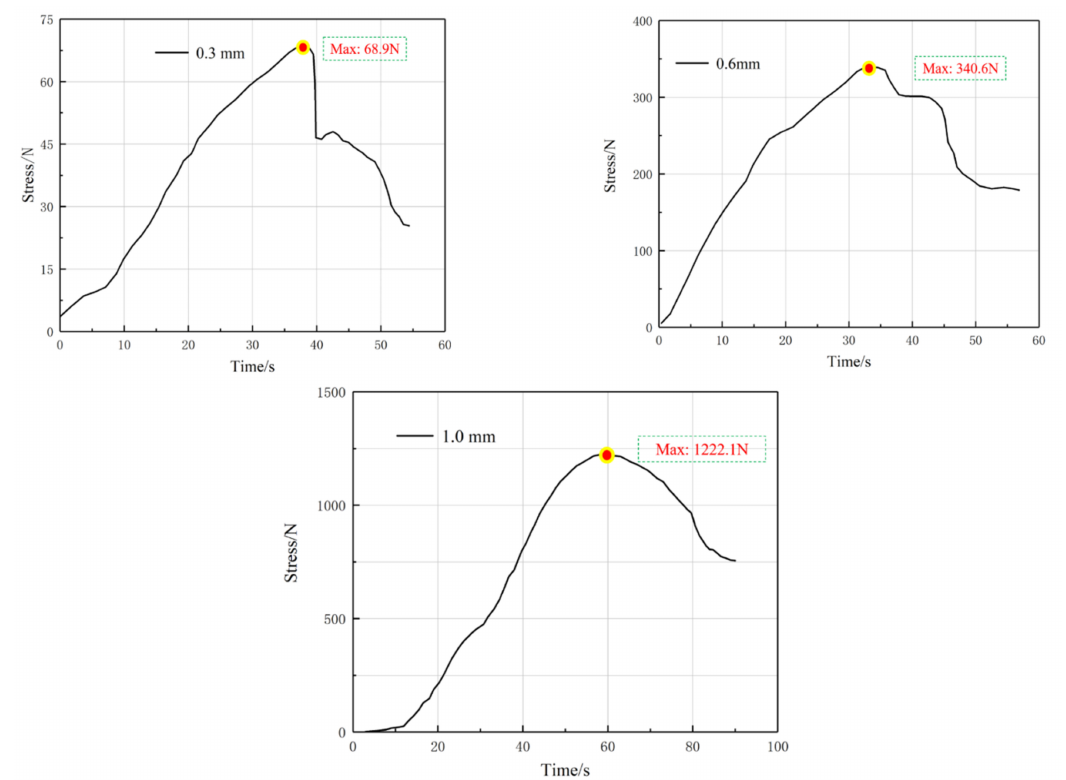
Figure 14. Loading curves for different thicknesses of the top plate. ( a ) Plate thickness 0.3 mm;